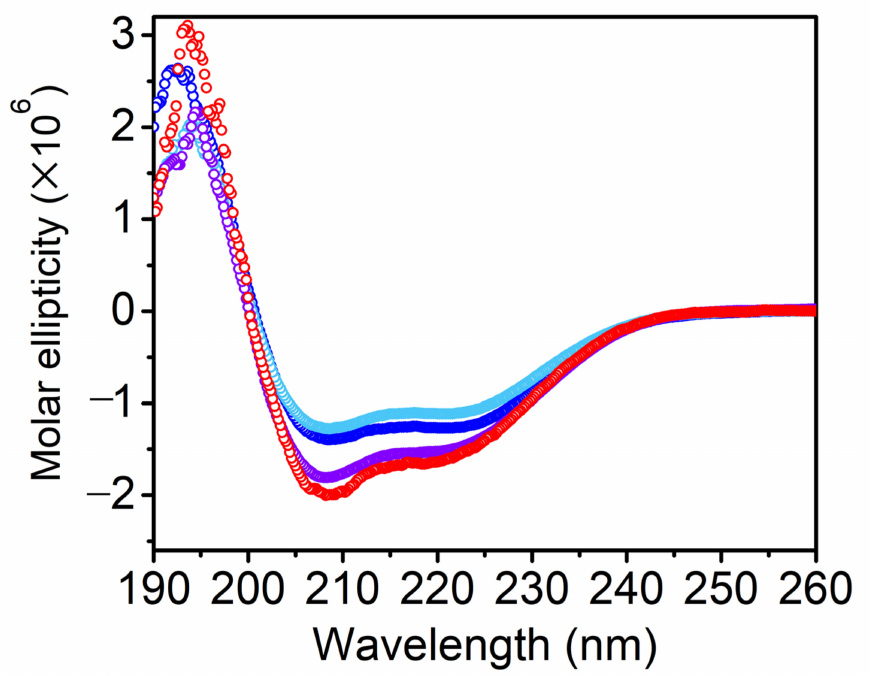
Figure 2. The CD spectra of Vpr solubilized in DPC detergent micelles (red), in DOPG proteolipo- somes (purple), and DOPG proteoliposomes in the presence of 5% (blue) and 10% cholesterol (light blue). The ellipticity corresponds to the α -helical content of Vpr is similar in DPC and in DOPG liposome. Vpr maintains similar α -helical structure content in different environments.